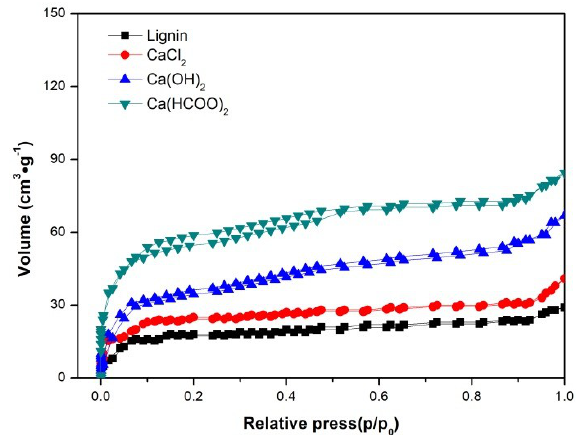
Figure 4. N 2 adsorption–desorption isotherm of chars from lignin pyrolysis with and without calcium salt additives. Table 2. The specific surface area and pore structure of chars from lignin pyrolysis with and without calcium salt